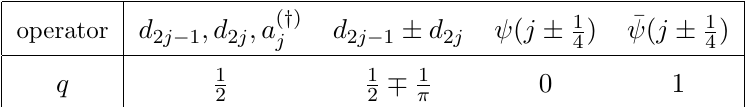
Table 1 . The locally excited states we consider in critical Ising spin chain. In the (cid:12)rst row we give the operators that excite the states. In the second row q is calculated as the ratio of the anti-holomorphic part, i.e. left-moving parts in our